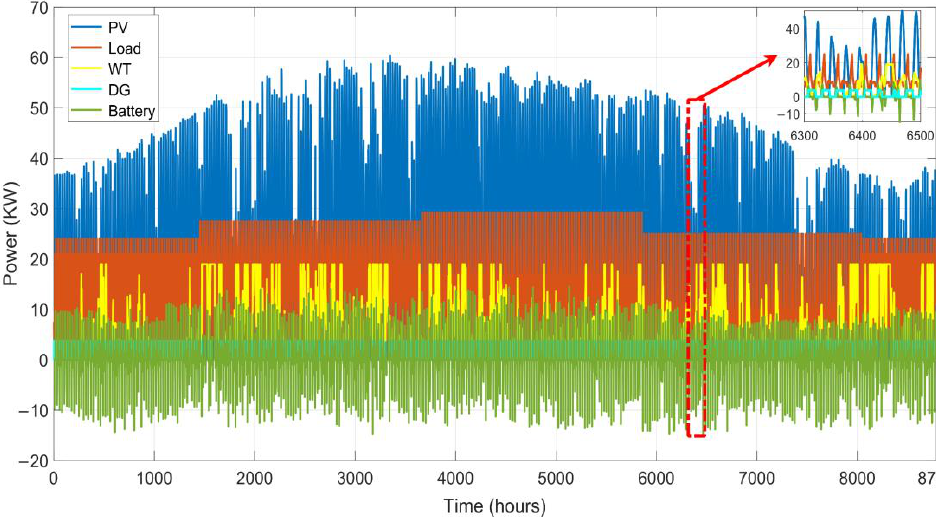
Figure 19. Power generation of the hybrid stand-alone microgrid system over one year.